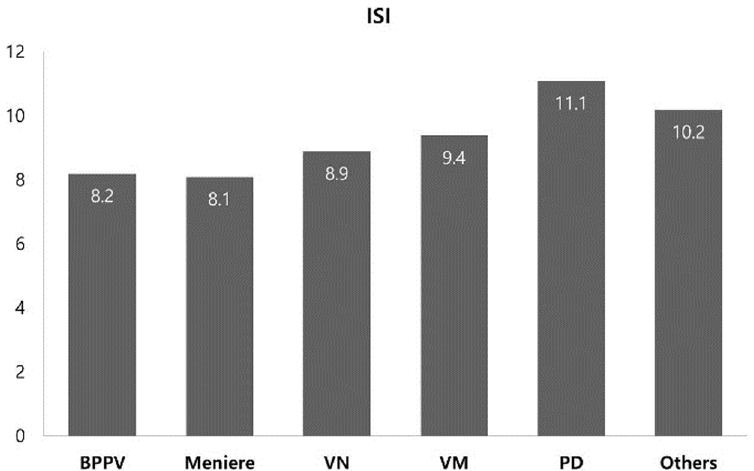
Fig 2. The mean ISI scores for each group. The mean ISI score of all subjects was 9.3 and was highest in the PD group, similar to PSQI. However, there were no significant differences between the